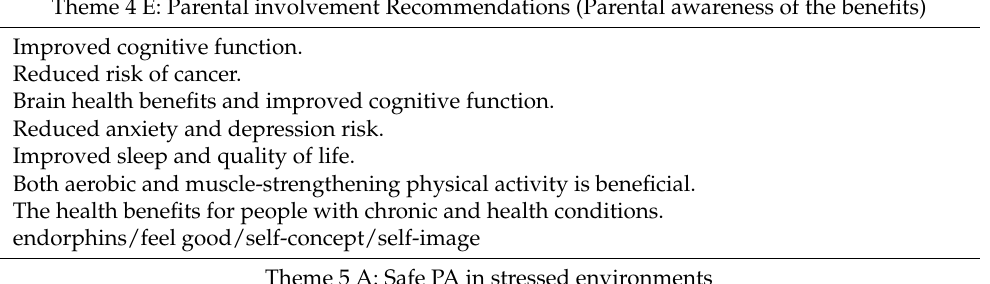
Table 1. Cont. Themes and Sub-Themes Theme 4 E: Parental involvement Recommendations (Parental awareness of the